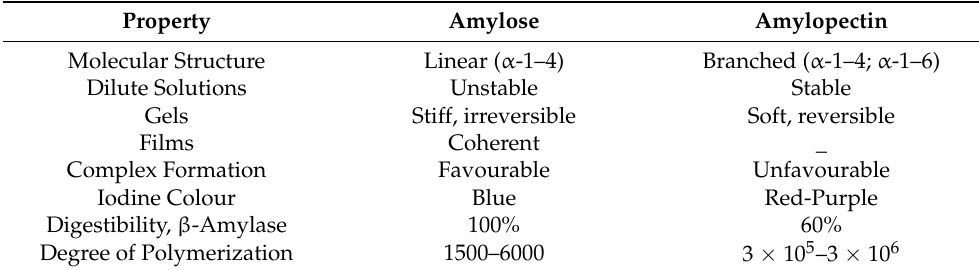
Table 3. Properties of starch fractions in rice endosperm [29].